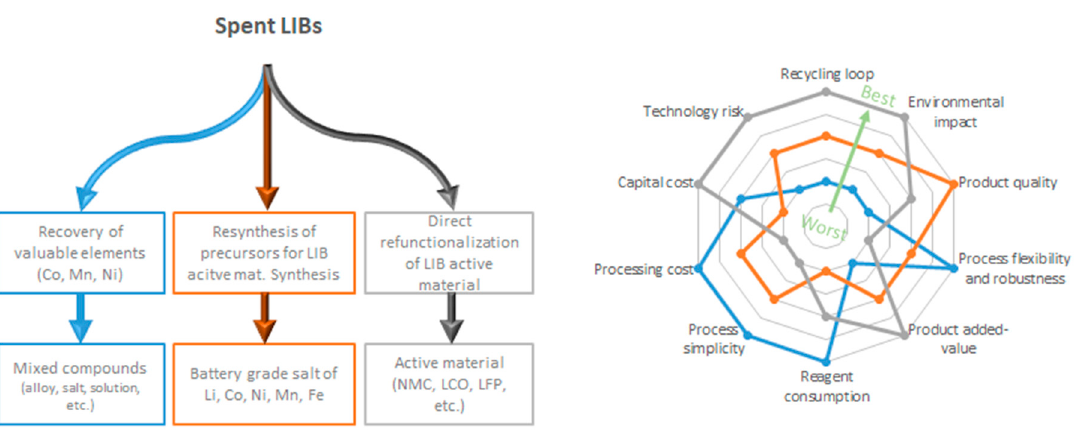
Figure 6. Schematic flow and comparison of three approaches for recycling spent Li-ion batteries (LIBs).